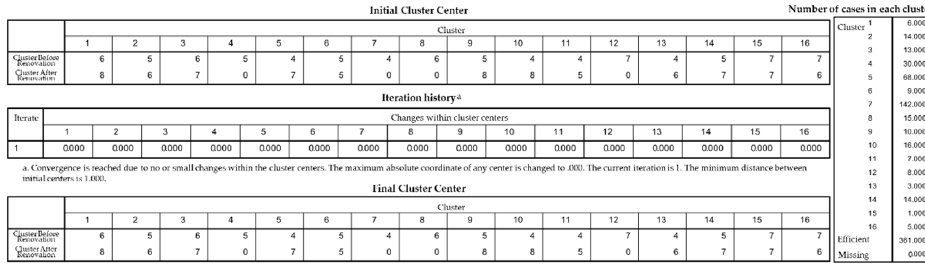
Figure A6. K ‐ means clustering analysis of changes in the attributes of other buildings.